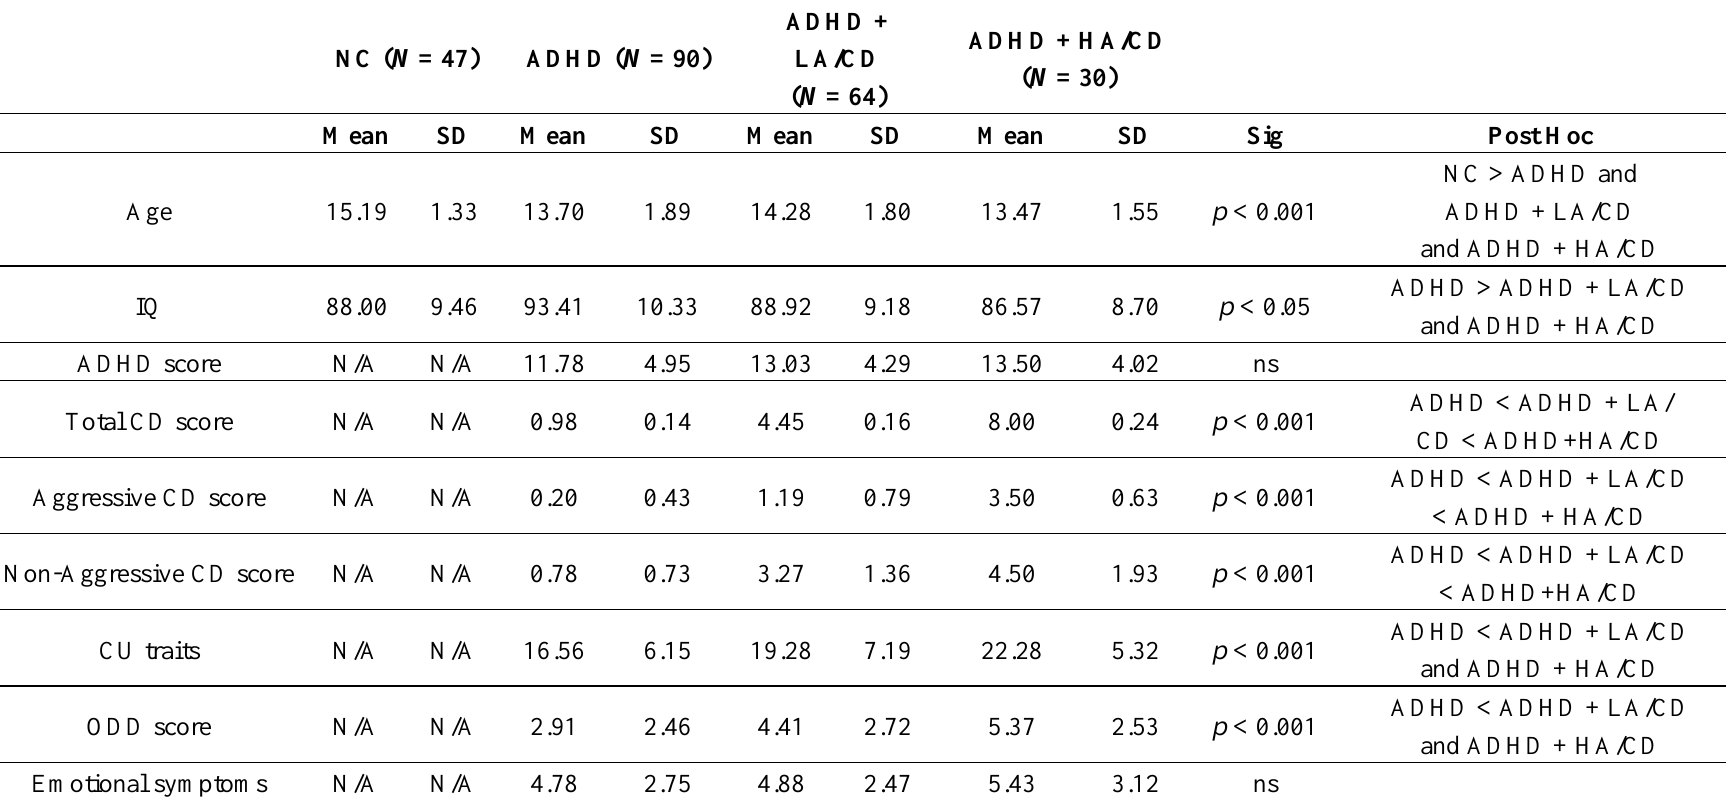
Table 1. Demographic characteristics of the